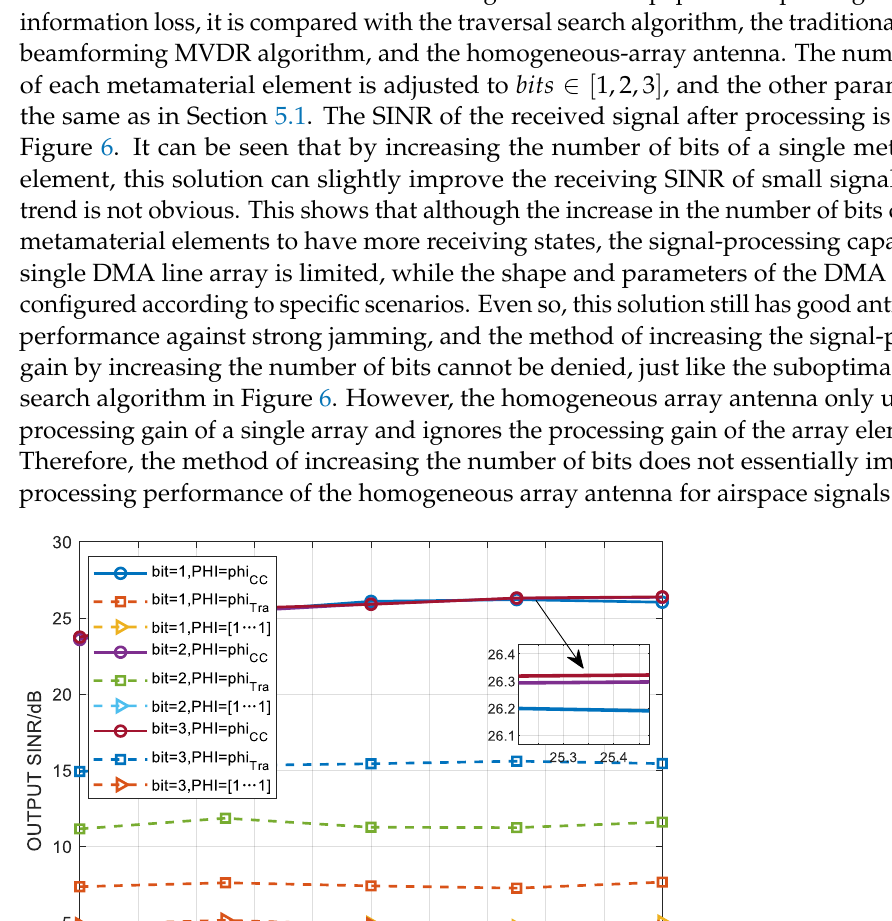
Figure 7. Comparison of anti-jamming performance of different algorithms based on metamaterial element spacing. 5.3.4. Effect of Strong Main Lobe Jamming In order to further analyze the performance of this scheme against strong main-lobe jamming, we set strong jamming signal sources in the range of 2° deviation of small signal